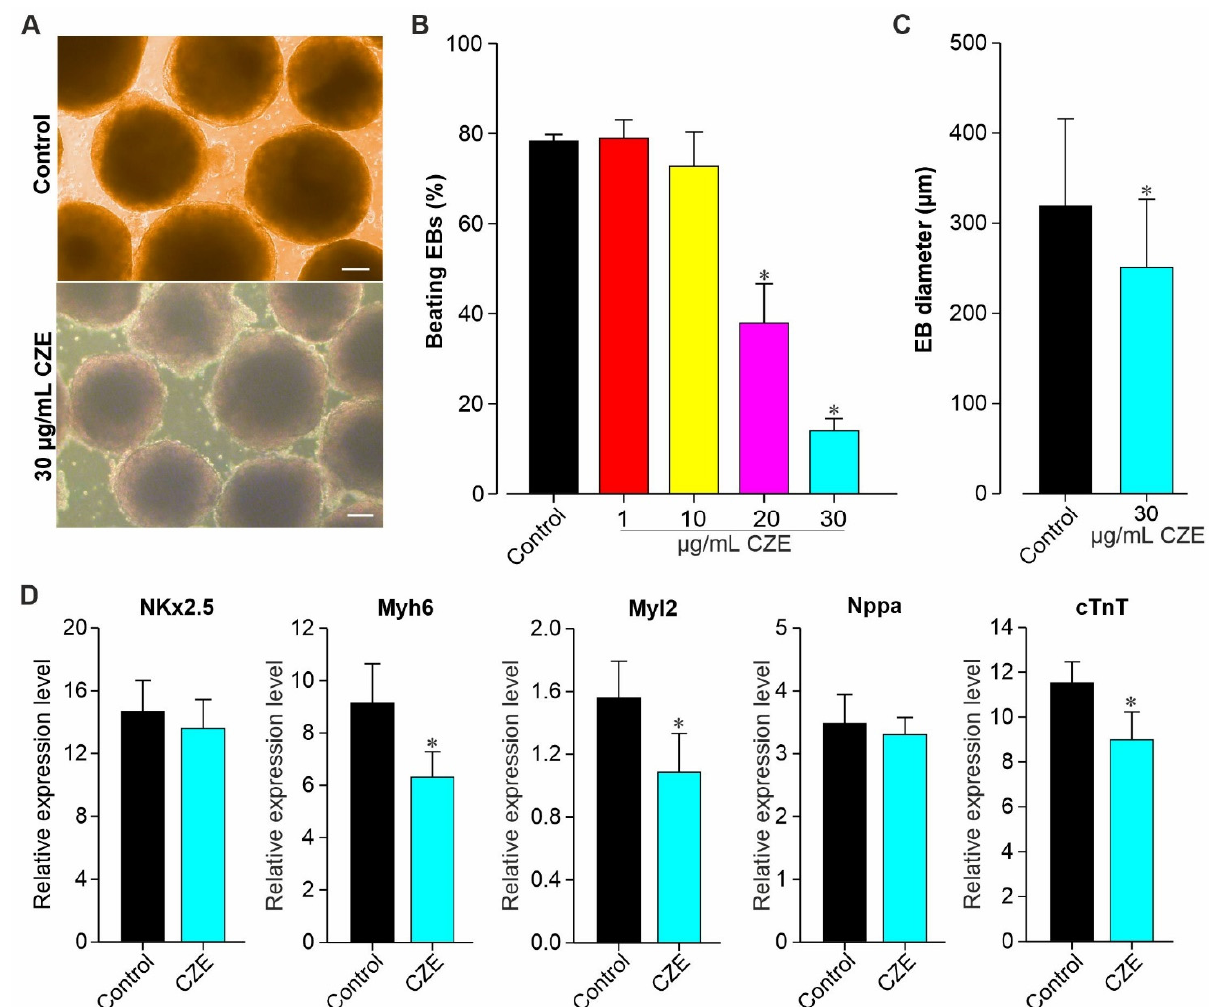
Figure 2. Effect of CZE on the morphology of embryoid bodies (EBs) and on cardiac marker expression genes. ( A ) Representative image of day 12 EBs cultured with 0 (control) and 30 µg/mL of CZE. ( B ) Effect of CZE concentration on the percentage of beating EBs at day 12 of differentiation. ( C ) Size (mean diameter) of control and 30 µg/mL CZE-treated EBs at day 12 post-cardiac differentiation. ( D ) Gene expression levels in CMs from control and CZE-treated EBs. Expression level of cardiac genes NKx2.5, Myh6, Myl2, Nppa, and TnT was detected using qRT-PCR. GAPDH was used as housekeeping gene and served to normalize the result. Scale bar = 50 µm. Results are reported as the mean ± SEM ( n = 3 independent experiments). * p < 0.05 vs. control CMs.